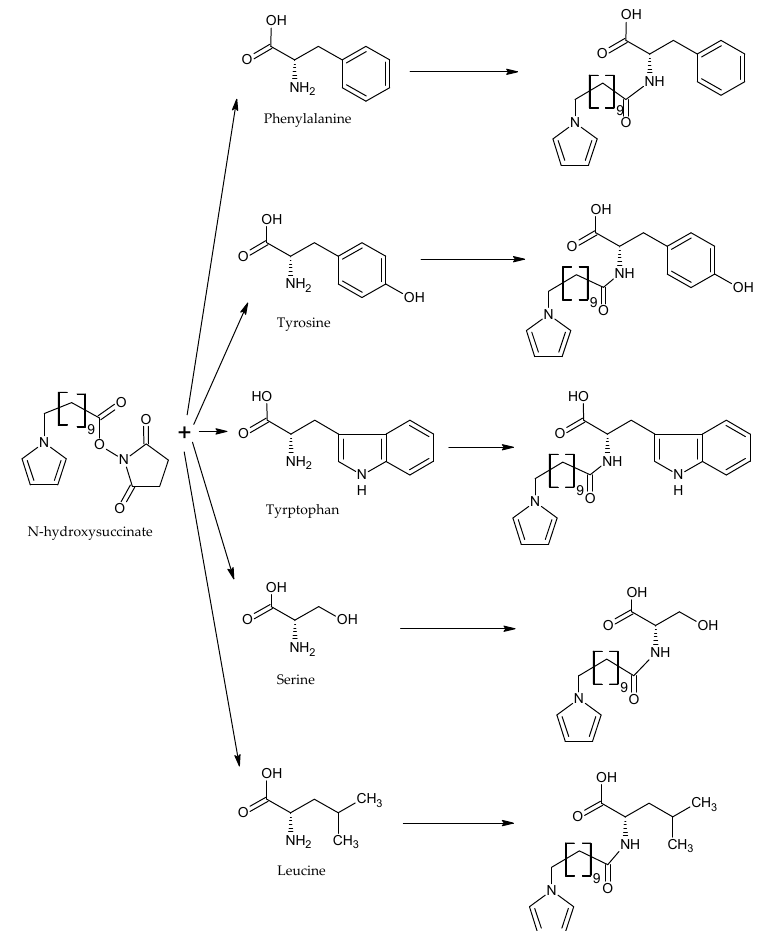
Figure 8. Reactions between N-hydroxy succinate and AAs. Adapted from [50] .